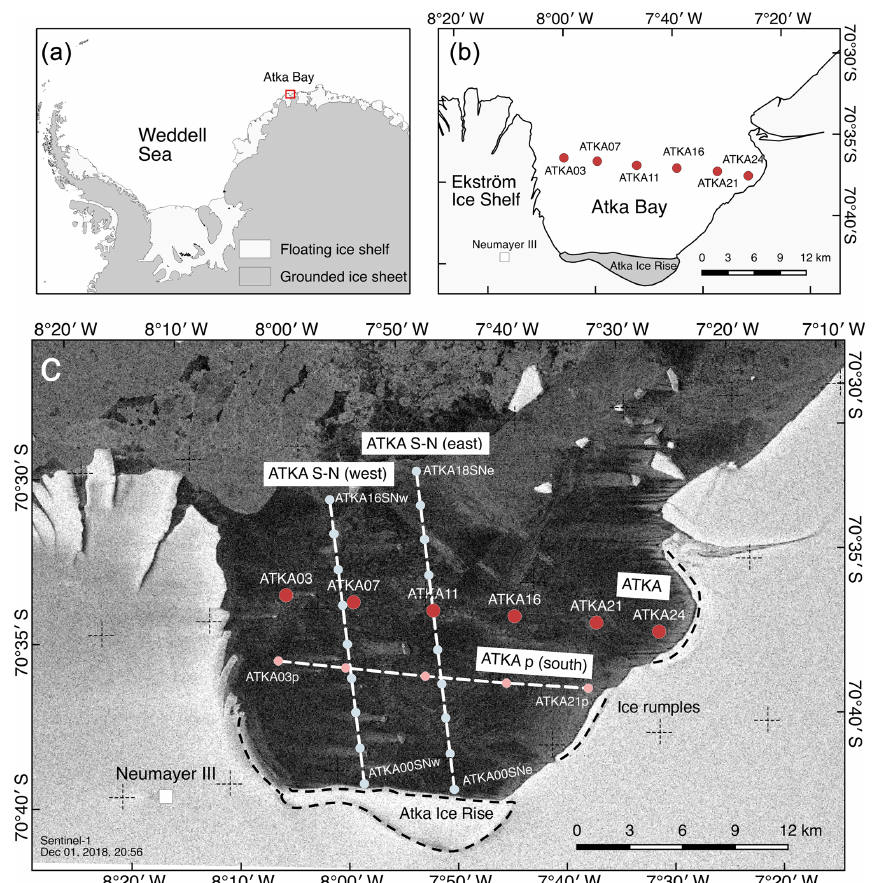
Figure 1. Overview of the study site and its surroundings. (a) Atka Bay (red marker) is located at the edge of the northeastern Weddell Sea. Coastline data taken from SCAR Antarctic Digital Database. (b) Close-up of map (a) to focus on the study site of Atka Bay. The sampling sites of the standard transect (ATKA) are marked with red circles. (c) Enlargement of (b) showing in addition to the standard transect (red circles) the parallel transect in the south (ATKA p; light red circles) from ATKA03p to ATKA21p as well as the eastern and western perpendicular transects ATKA S-N (east) from ATKA00SNe to ATKA18SNe and ATKA S-N (west) from ATKA00SNw to ATKA16SNw, each with a distance of 2km between adjacent sampling sites (light blue circles). The southern, eastern, and western transects were sampled during a field campaign between November and December 2018. The dotted black curves indicate the locations of ice rises and rumples in Atka Bay. Background: Copernicus Sentinel data from 1 December 2018, processed by